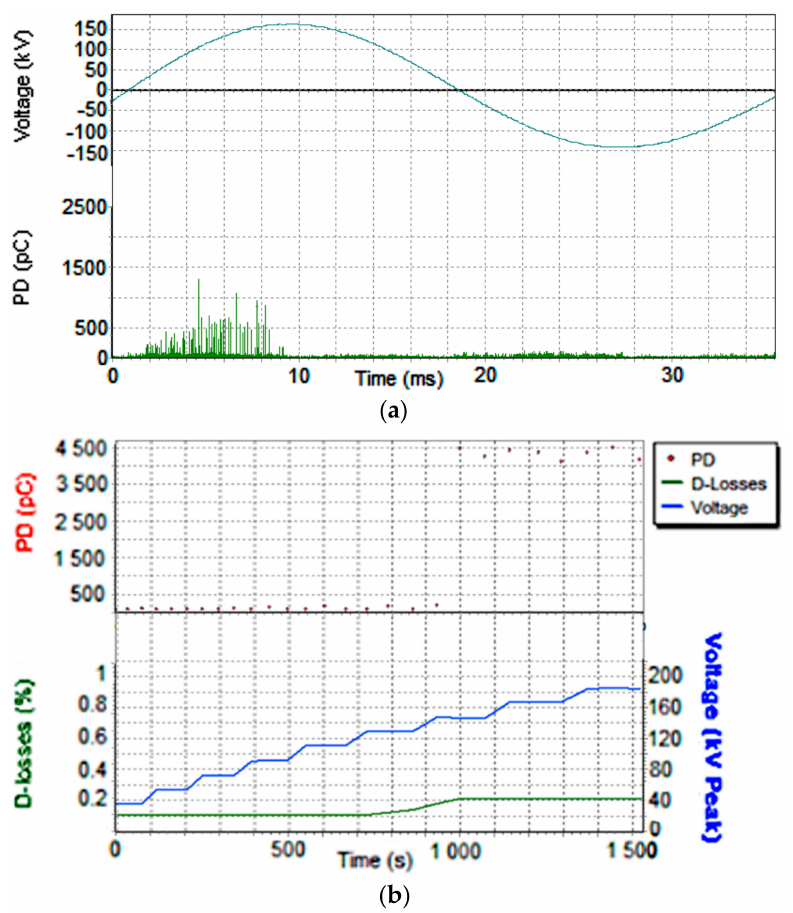
Figure 5. Test result overview of the PD-monitored ramp-up test ( a ) Obtained phase-resolved PD pattern at 1.8 Uo, ( b ) Overview of the ramp-up test from 0.4 Uo to 2.0 Uo prior to the voltage withstand test, duration 25 min.